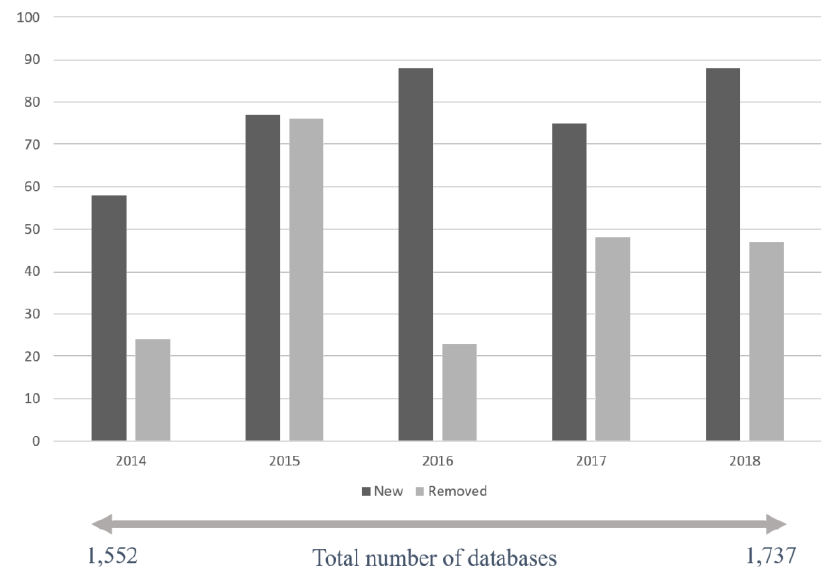
Figure 1. Number of biological databases added and removed from the NAR catalog in the last 4